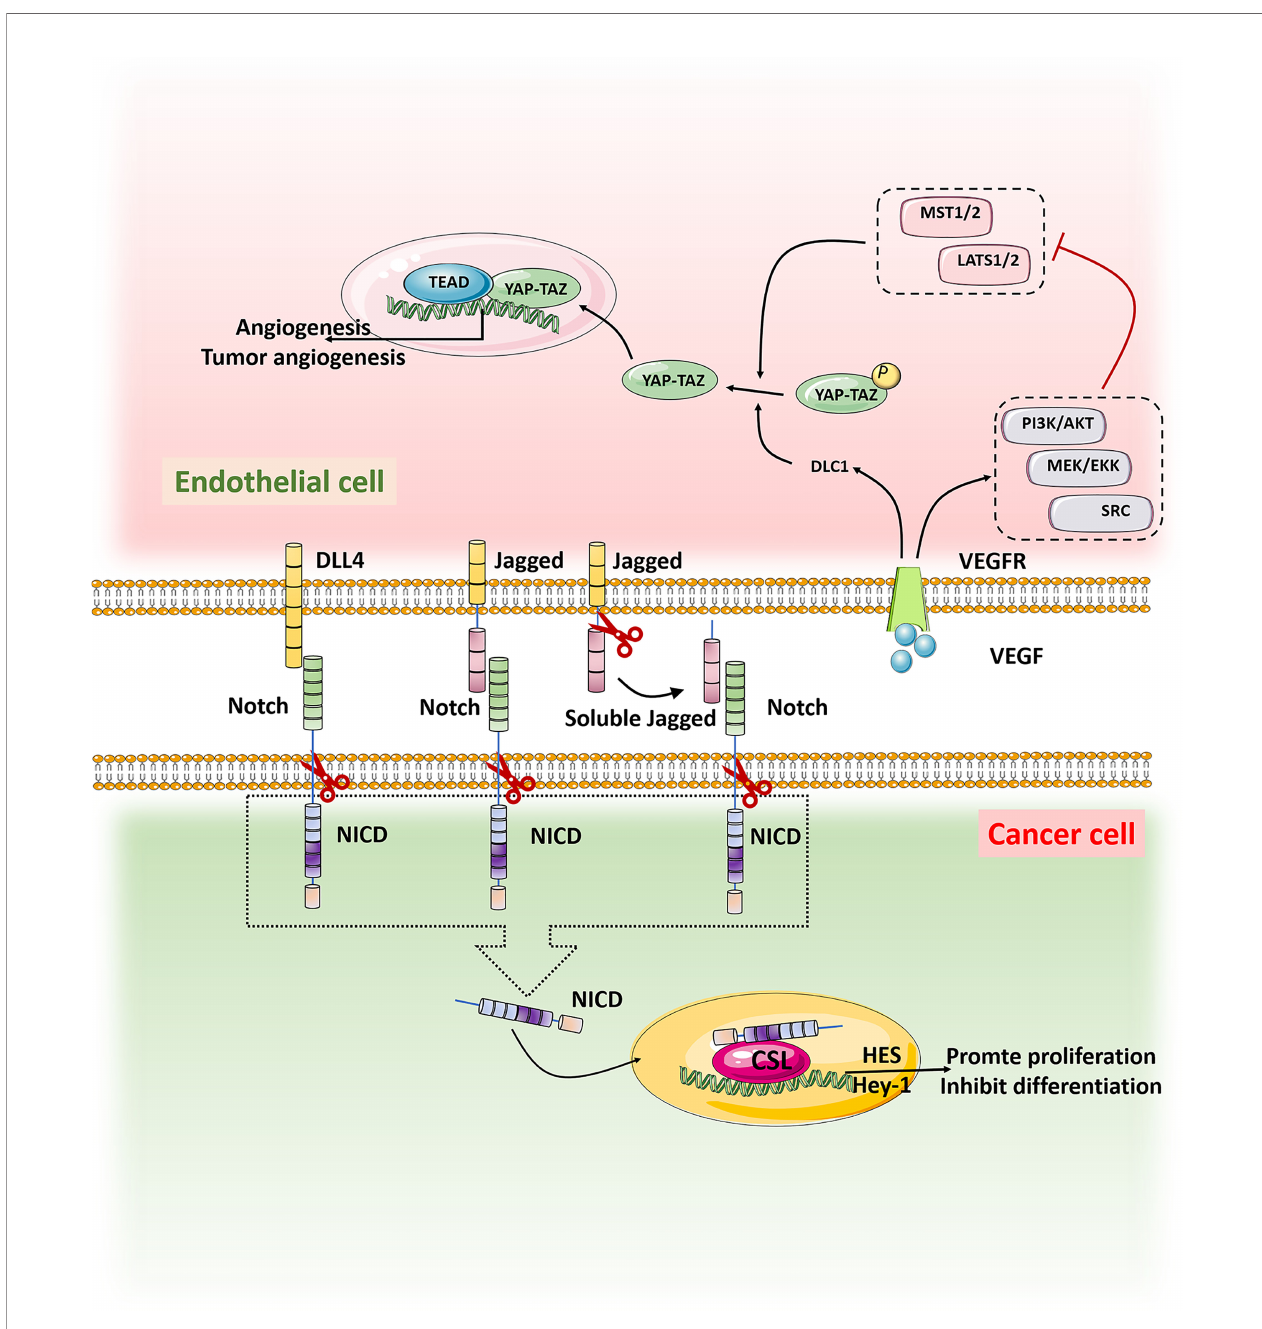
FIGURE 3 | When Notch on tumor cells binds to ligands DLL4 and Jagged on TECs, it is activated and cut by Y secretion to release the Notch intracellular domain NICD, which is translocated into the nucleus by activating transcriptional targets HES and Hey1 to inhibit differentiation and maintain stemness. VEGF in the tumor microenvironment binds to the receptor VEGFR on TECs, promoting the expression of tumor suppressor gene DLC1 and the activation of signaling pathways such as PI3K/AKT, MEK/EKK and SRC, thus inhibiting the activation of MST1/2-LATS1/2 kinase cassette. YAP/TAZ was dephosphorylated and translocated into the nucleus. In the nucleus, YAP/TAZ interacts with the transcription factor TEAD to promote tumor genesis and